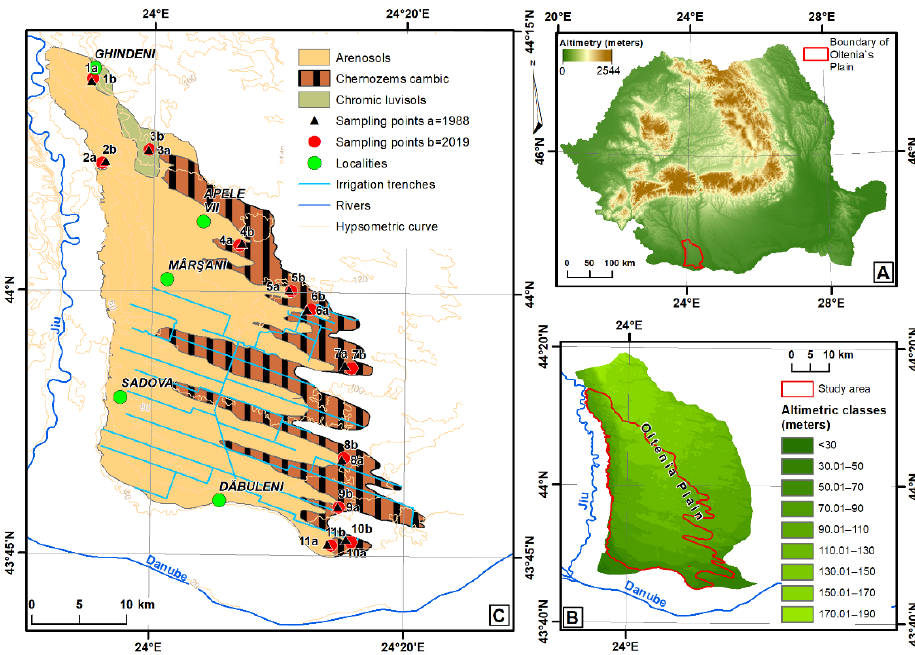
Figure 2. Soils map and sampling points (( A )—the geographical location of the Oltenia’s Plain within Romania, ( B )—the geographical location of the study area within the Oltenia’s Plain, ( C )—the numbers represent soil profiles sampled from the field).